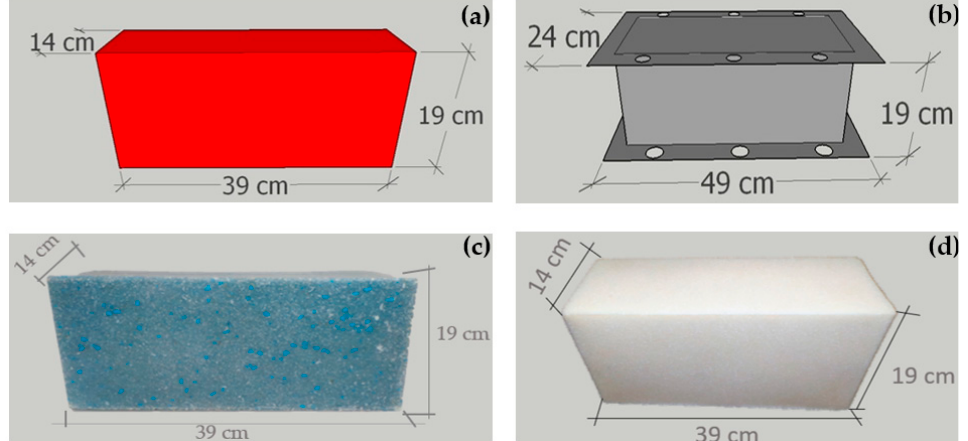
Figure 2. Modeling, molds, and blocks: ( a ) modeling the rotomolded block; ( b ) modeling the mold; ( c ) PP rotomolded block; ( d ) HDPE rotomolded block. ( c ) PP rotomolded block; ( d ) HDPE rotomolded